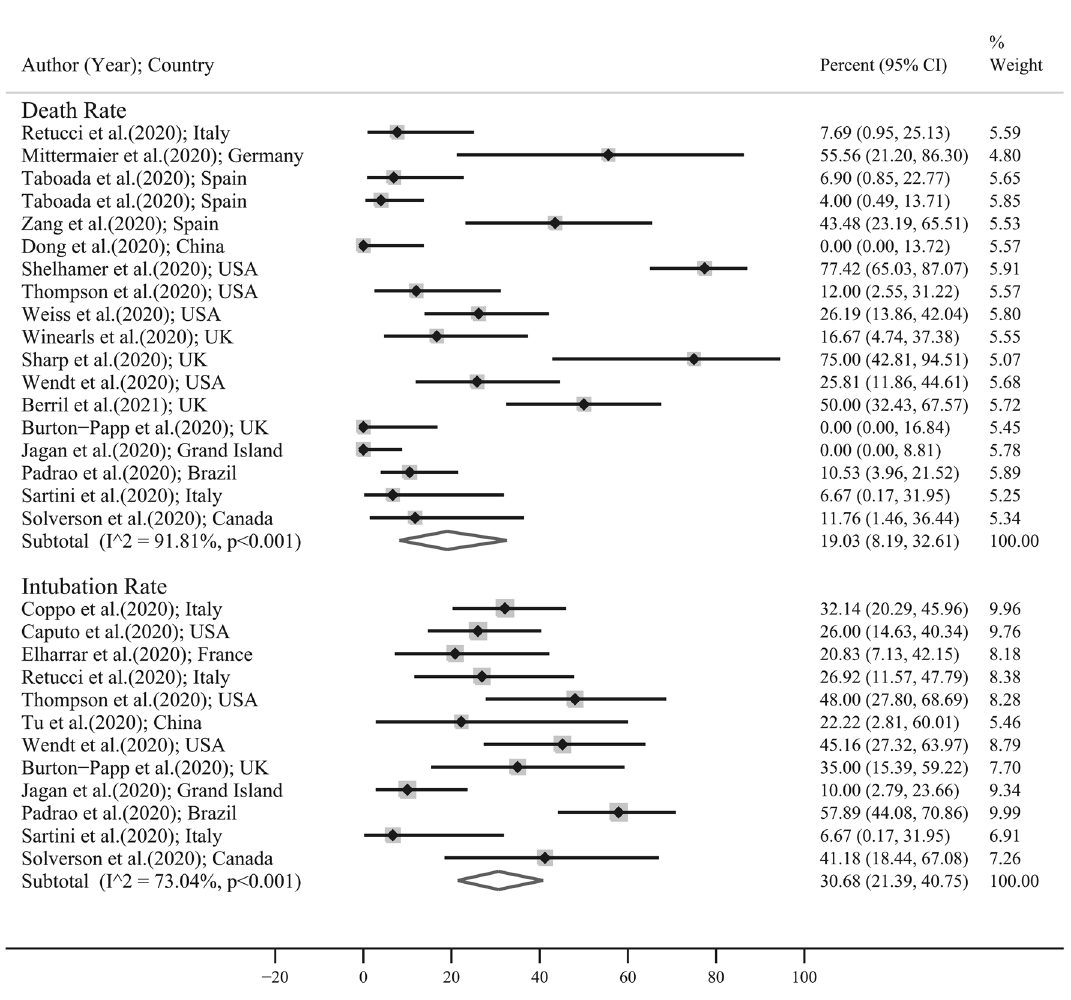
Figure 4. Forest plot for death rate and intubation rate in included studies. The diamond mark illustrates the pooled estimate and length of diamond indicates 95% confidence